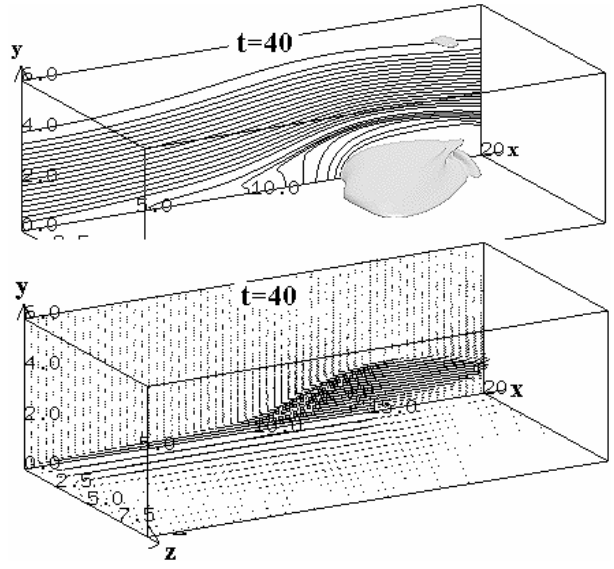
Fig. 3. Magnetic field and plasma flow configurations for the anomalous resistivity model (Eq. 4) with V C = 12 in an open sys- tem; in the upper panel, the plasmoid is shown by the isosurface of plasma